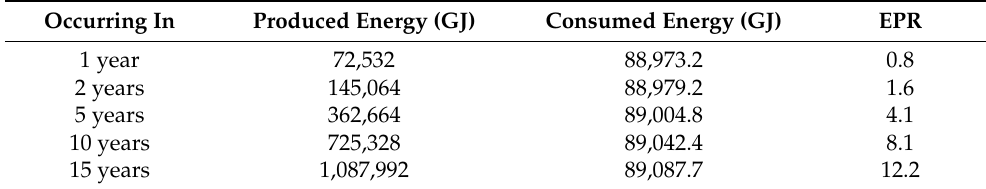
Table 15. Changes in the produced and consumed energy considering a catastrophic failure in the whole system. Occurring In Produced Energy